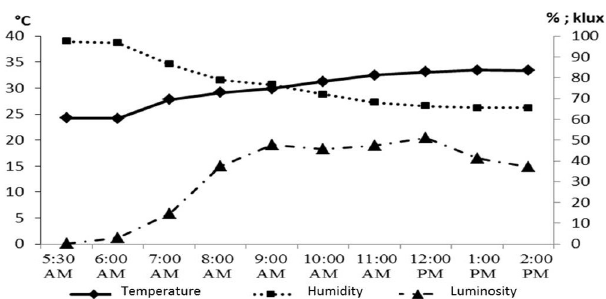
Fig 3 .Temperature (°C), relative air humidity (%) and luminosity (klux) inside the greenhouse where the mini watermelon ( Citrullus lanatus ) was cultivated and pollination services by stingless bees were required.